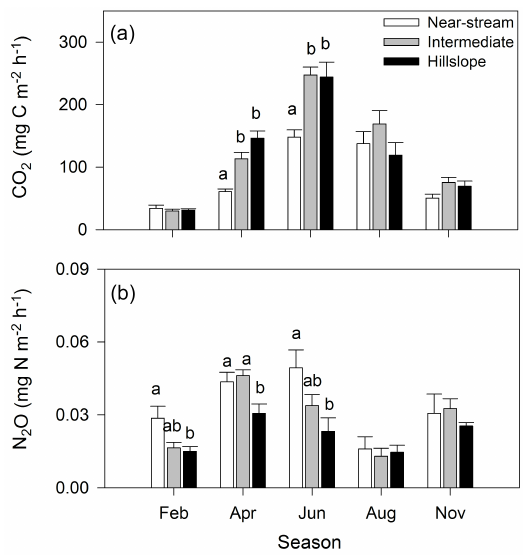
Figure 5. Temporal pattern of soil (a) CO 2 and (b) N 2 O emissions at the near-stream (white), intermediate (grey), and hillslope (black) zones during the study period. Bars are mean values for each section and error bars are standard errors. For each season, different let- ters indicate significant differences among sections (mixed-model ANOVA, p < 0 .